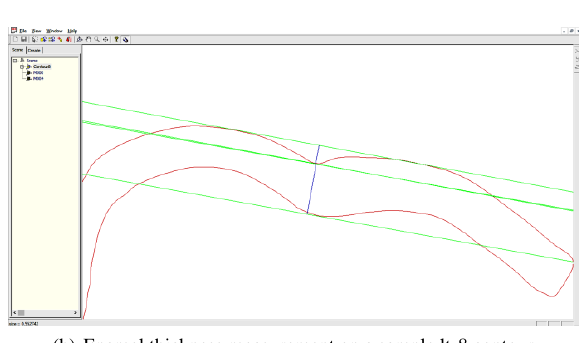
Figure 5. Orientation algorithms before and after manual adjustments.